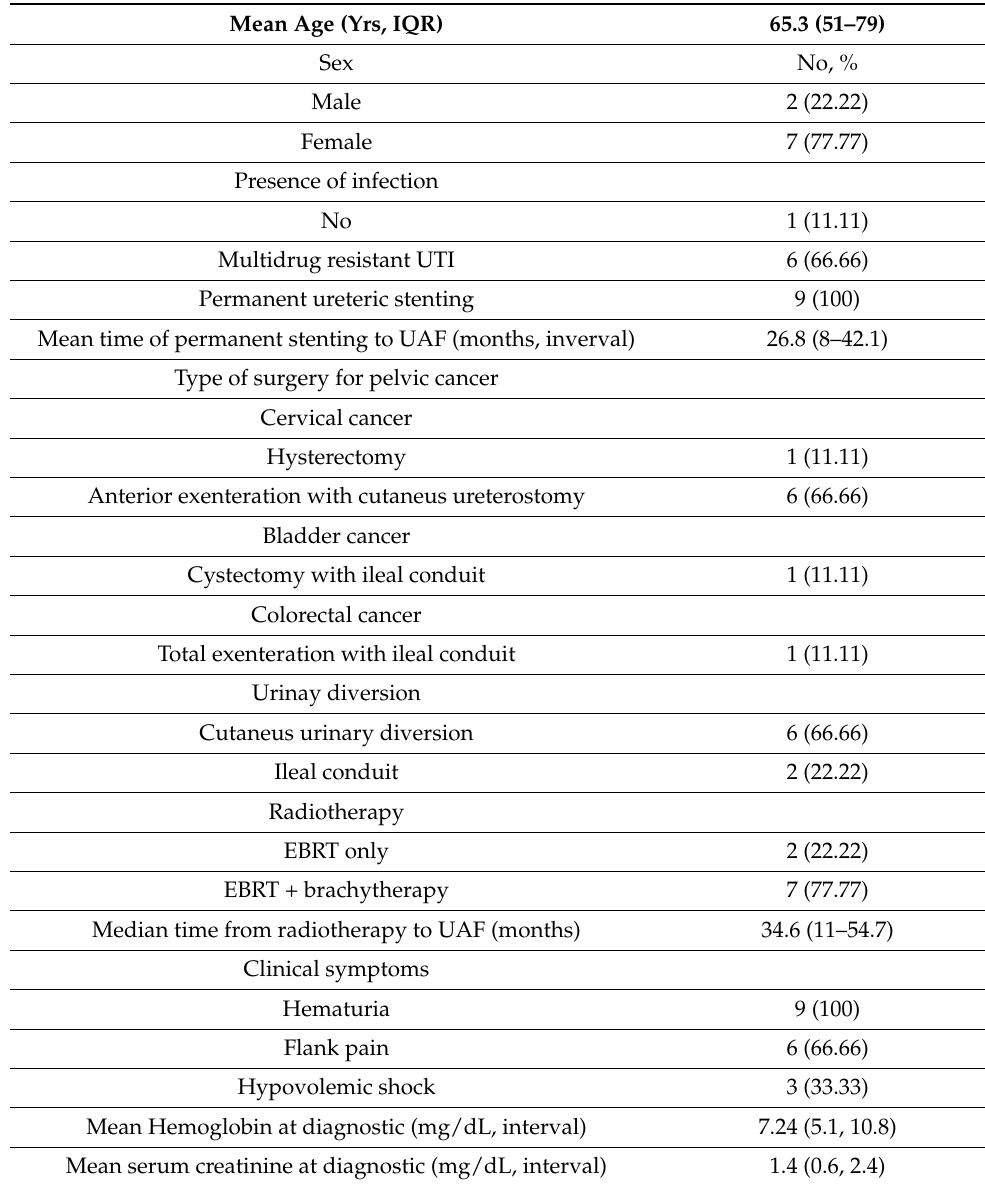
Table 1. Demographic data of patients from our cohort (UTI—urinary tract infection, EBRT—external beam radiotherapy, UAF—uretero–arterial